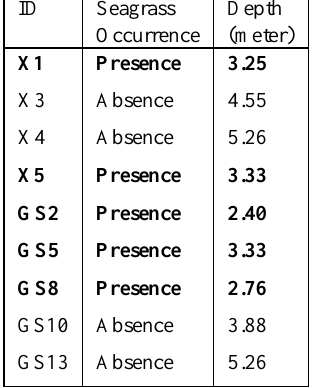
Table 1. The in-situ samples used in this